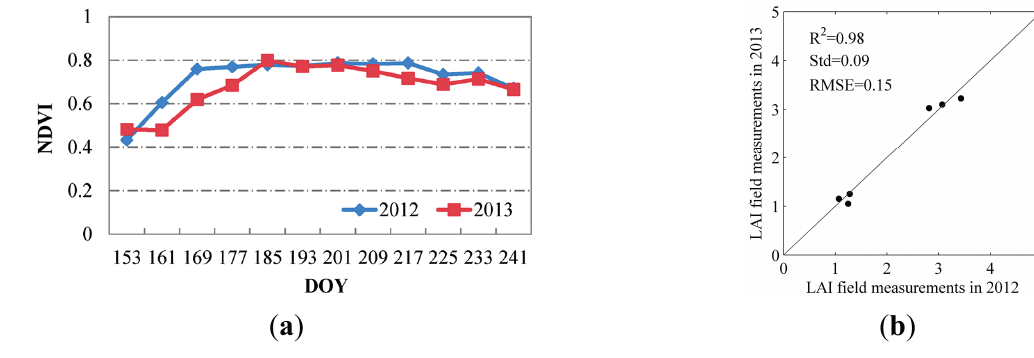
Figure 4. ( a ) Temporal profiles of mean MODIS NDVI for all of the selected LAI sample plots in the study area from the 153rd to the 241st day of 2012 (blue line) and 2013 (red line). ( b ) Comparison of the six corn sample measurements with similar observation times in 2012 and